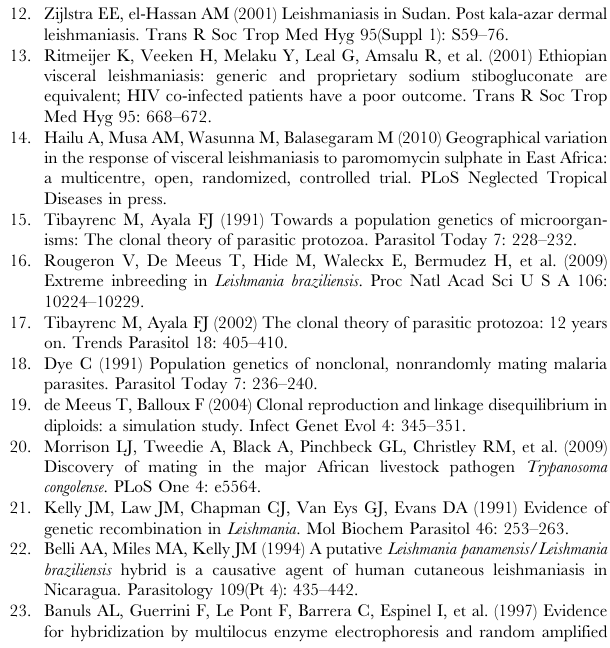
Table S1 Designation and characteristics of Leishmania donovani strains used in this study.